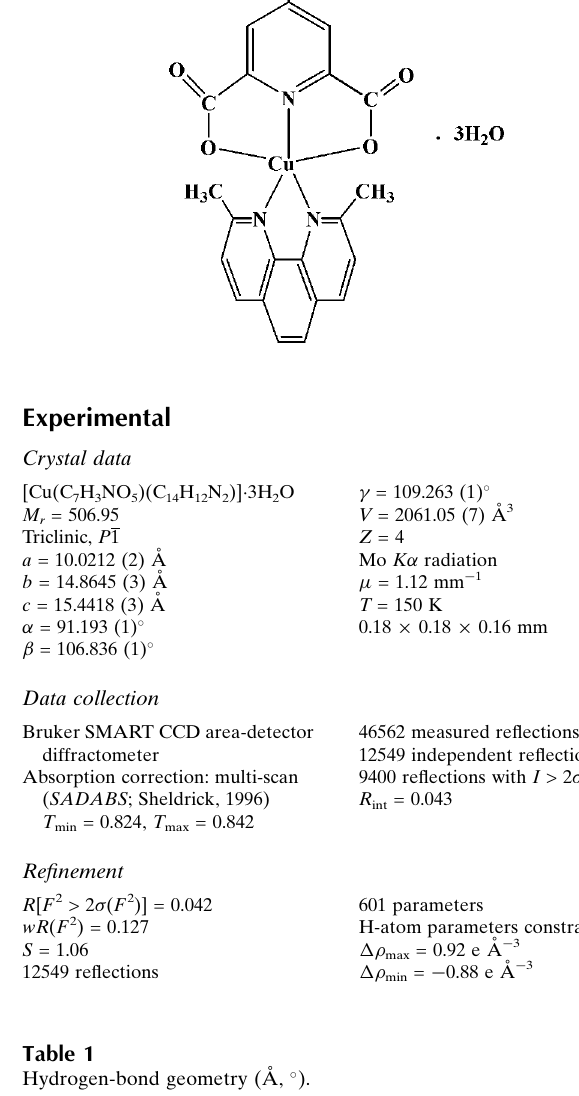
Hydrogen-bond geometry (A ˚ , (cid:3) ). D —H (cid:2)(cid:2)(cid:2)